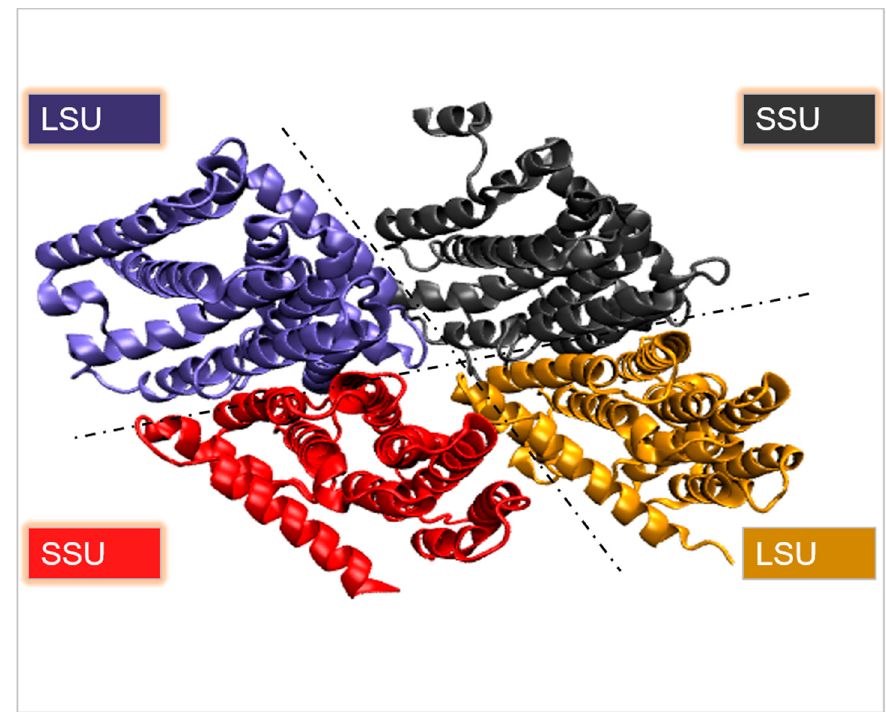
Figure 5. Crystal structure of geranyl diphosphate synthase (PDB: 3KRC). The different colors indicate the different subunits of the enzyme. Table 1. Research closely related to the key enzymes involved with the phytochemical compound’s biosynthesis in hops.